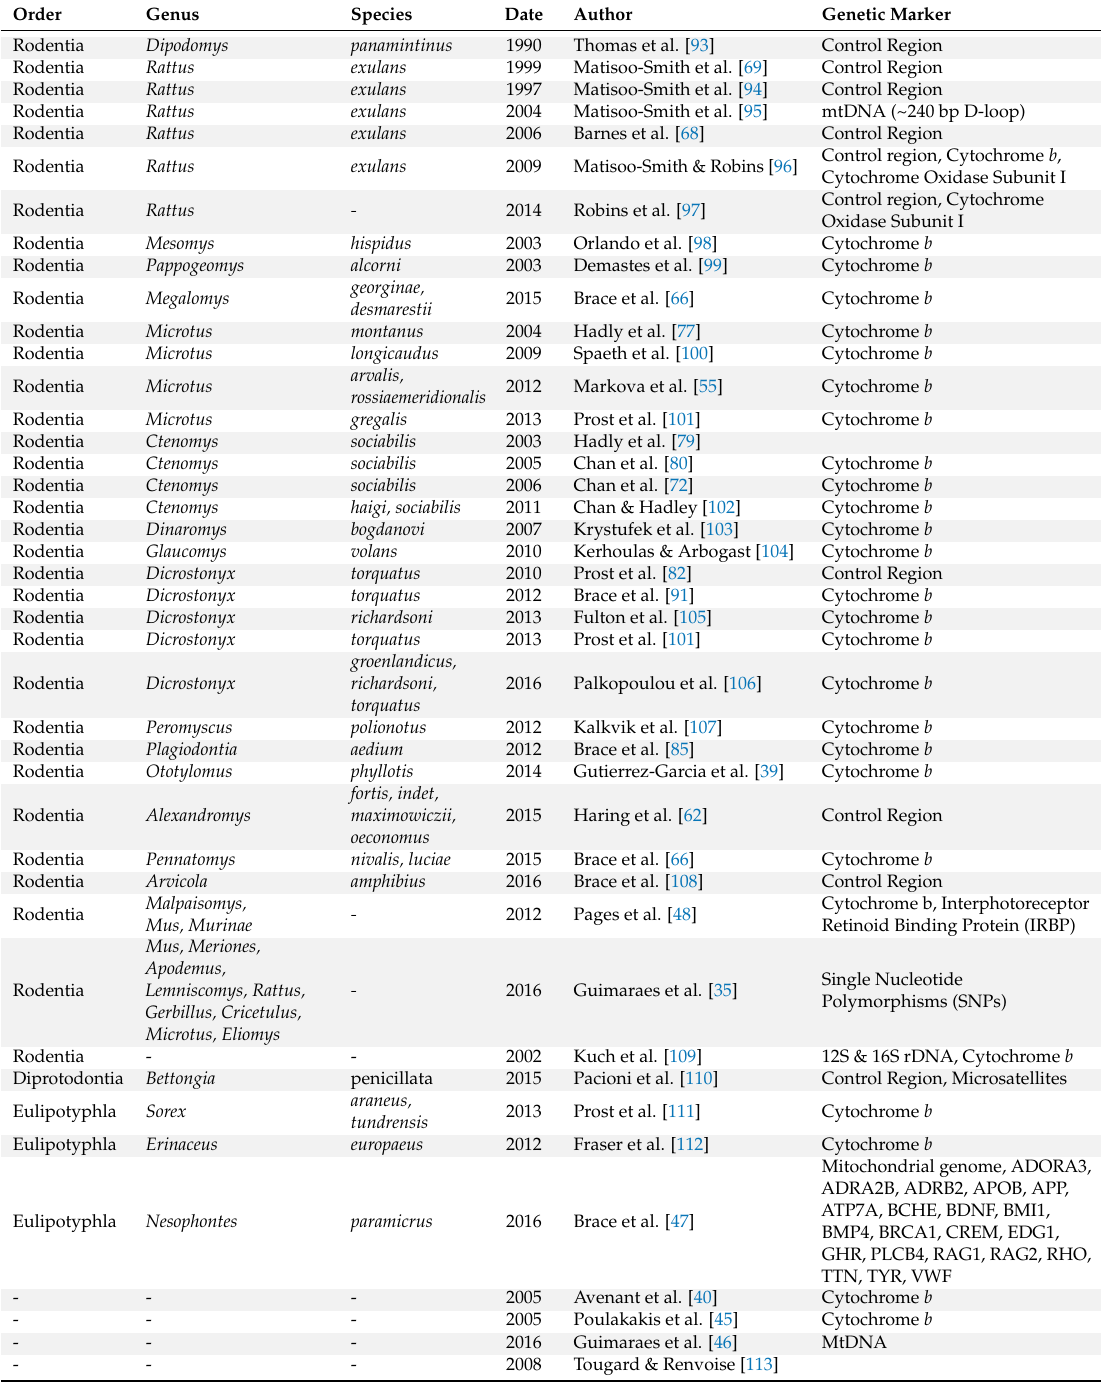
Table 1. Published studies from 1990 to 2017 in which ancient or degraded DNA was utilised to study micromammal